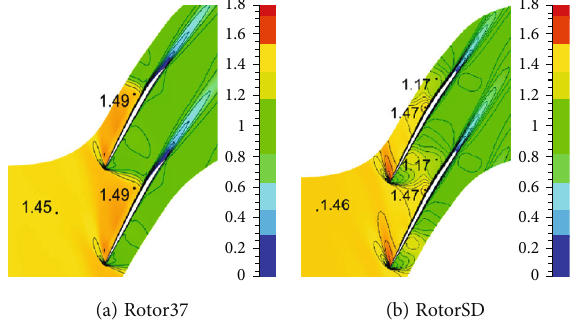
Figure 2: Contours of the relative Mach numbers at 90% span.